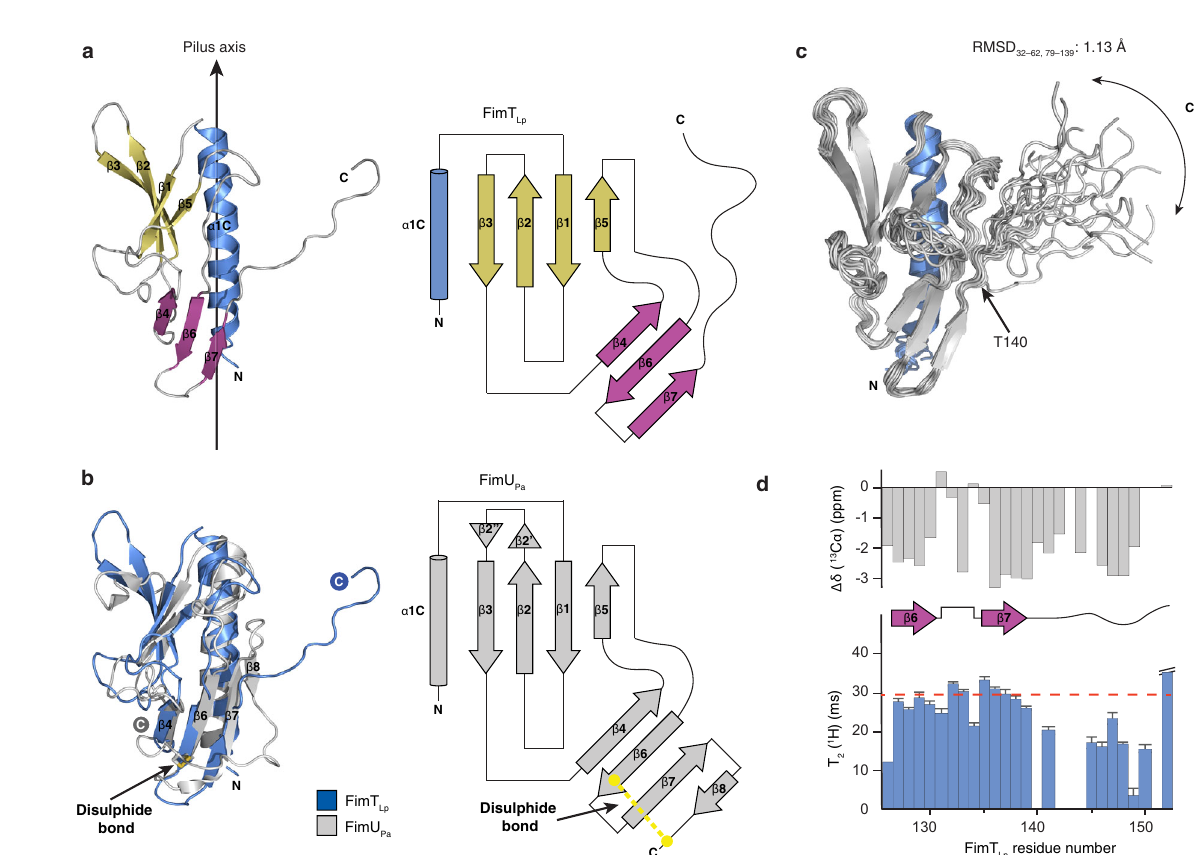
Fig. 2 The structure of FimT Lp . a The solution structure of FimT Lp 28 – 152 (state 18) in ribbon representation (left) and the corresponding topology diagram (right). Secondary structure elements are indicated: truncated N-terminal α -helix ( α 1C) (blue), β -sheet I formed by β 1, β 2, β 3, and β 5 (yellow), and β -sheet II formed by β 4, β 6, and β 7 (magenta). A vertical arrow indicates the pilus axis from the cell surface towards the pilus tip. b Structure alignment of FimT Lp (blue) and FimU Pa (grey; PDB ID: 4IPV) (left) and the topology diagram of FimU Pa (right). The disulphide bond of FimU Pa is indicated in stick representation with sulphur atoms in yellow. c Superimposed 20 lowest energy structures calculated by NMR spectroscopy. An arrow indicates the conformational fl exibility of the C-terminal tail (140 – 152). The pairwise backbone root-mean-square deviation (RMSD) for the structured region (residues 32 – 62, 70 – 139) is 1.13 Å. N- and C-termini are indicated in each panel. d C α chemical shift values (top) and T 2 ( 1 H) transverse relaxation data (bottom), encompassing the last 27 residues of FimT Lp . Secondary structural elements are indicated and error bars represent the fi tting errors of the respective exponential decay curves. Source data are provided as a Source Data fi